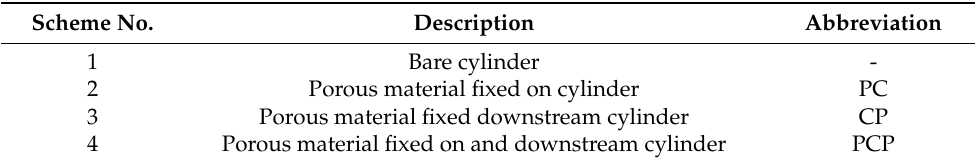
Table 1. Descriptions of the four numerical schemes. Scheme No.